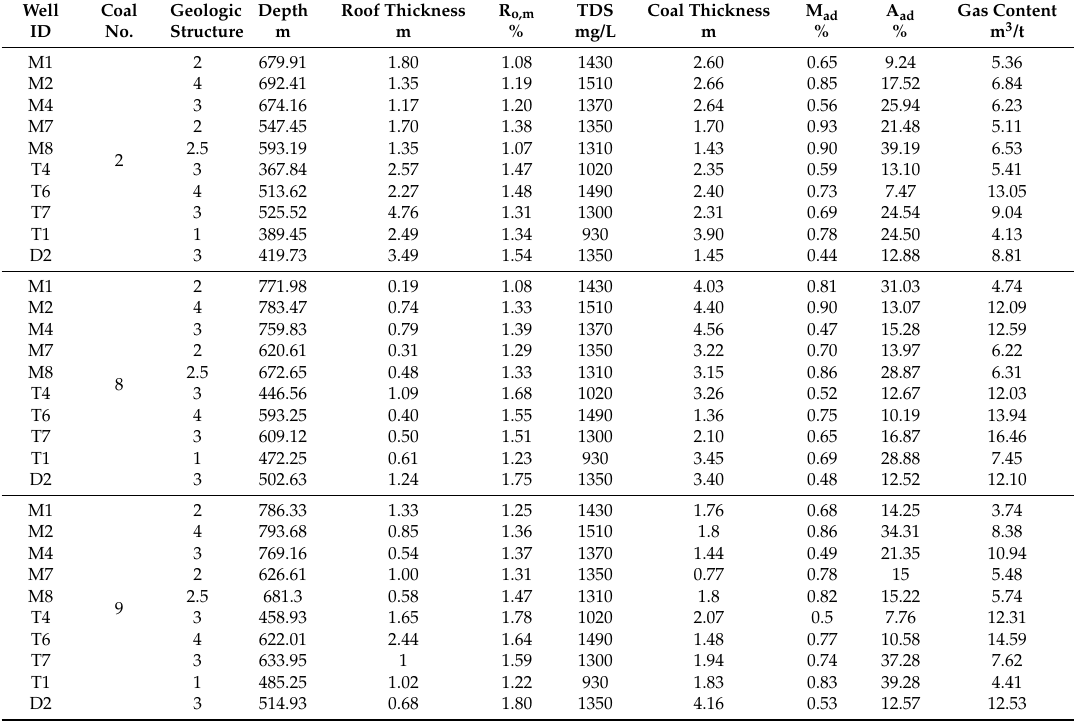
Table 2. Basic parameters for evaluating factors controlling gas